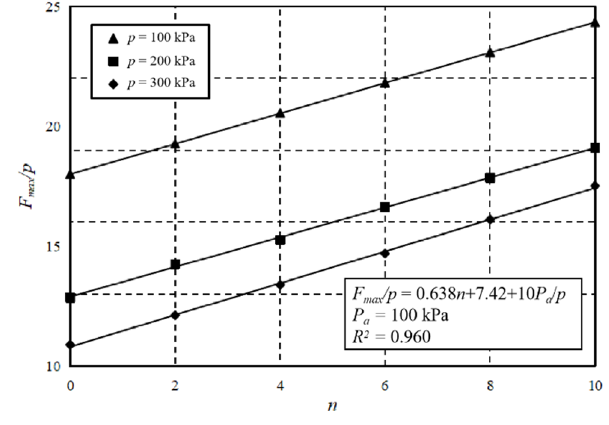
Figure 12. Normalized maximum axial load versus pressure ratio.